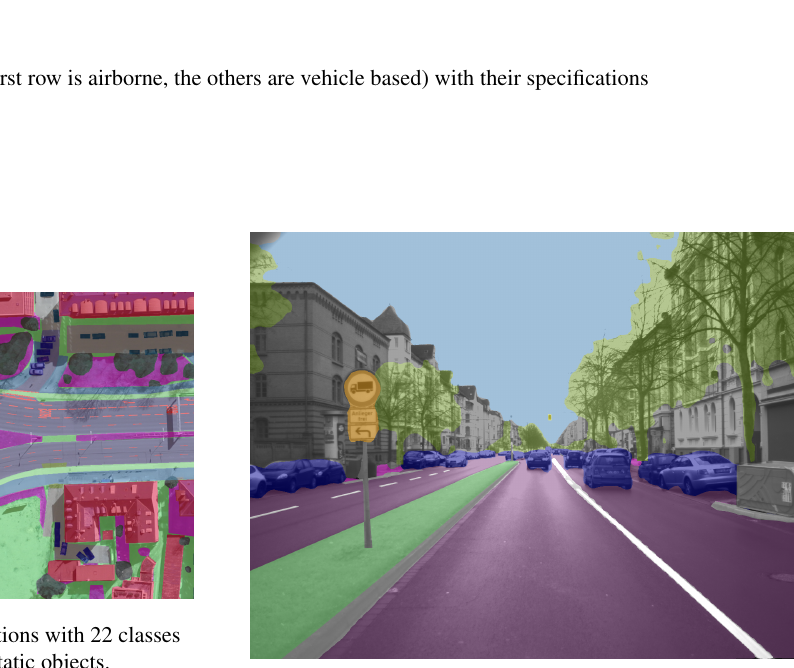
Figure 10. Example of pixel-wise annotations with 28 classes containing both static and non-static